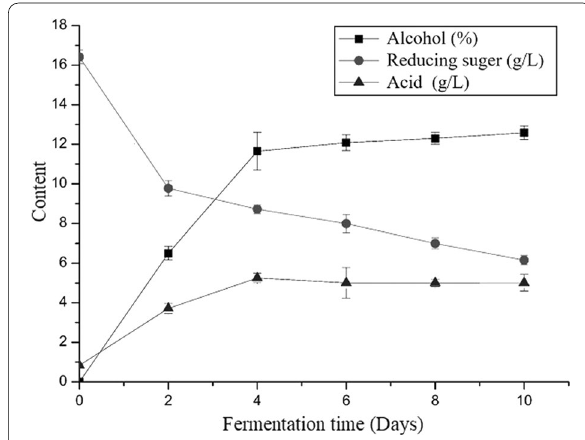
Fig. 1 The changes in alcohol, reducing sugar and acid during fermentation of northern Huangjiu. Square indicates the content of alcohol. Circle indicates the content of reducing sugar. Triangle indicates the content of